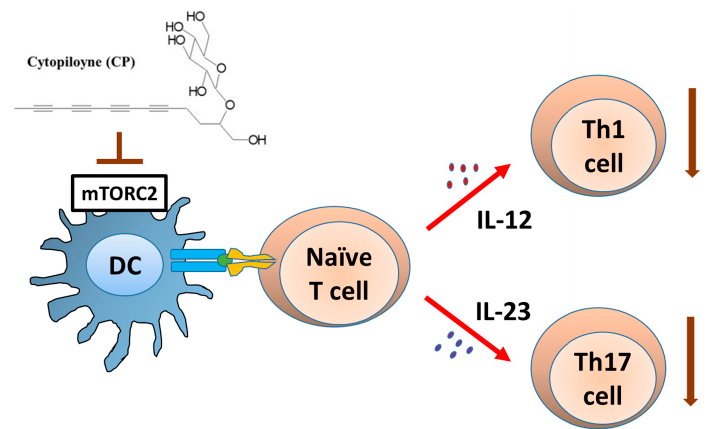
Figure 3. Immunomodulatory activity of cytopiloyne (CP). Blocking mTORC2 activity by CP can specifically inhibit LPS-induced expression of IL-12 and IL-23 in human DCs, resulting in the sup- pression of Th1 and Th17 activation.